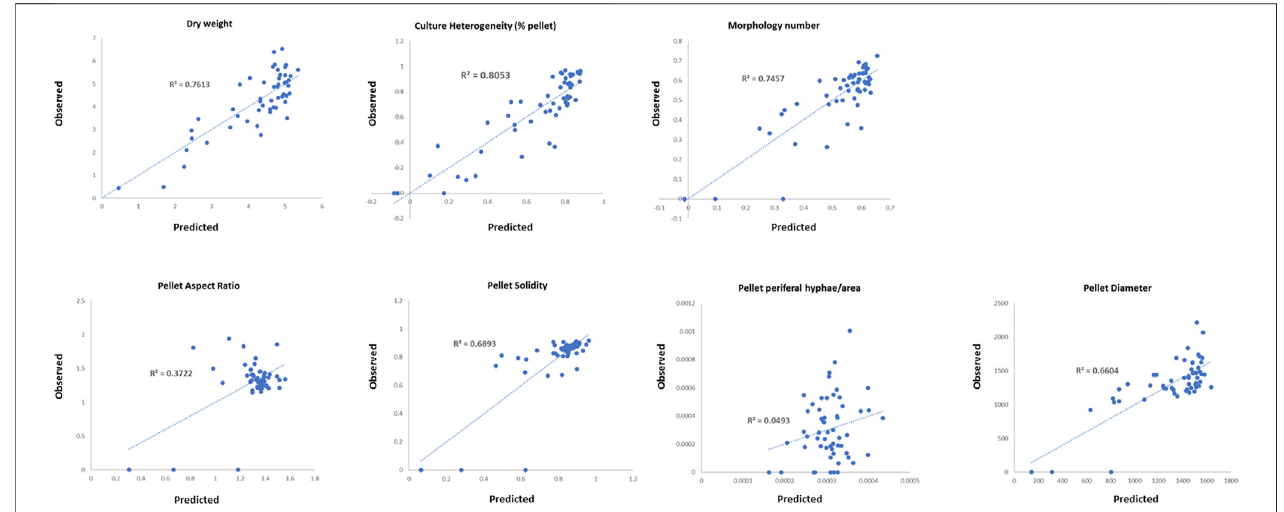
FIGURE 6 | Multiple linear regression analysis of the conditional expression library. Correlations between values predicted for each strain/Dox concentration and those observed are given.